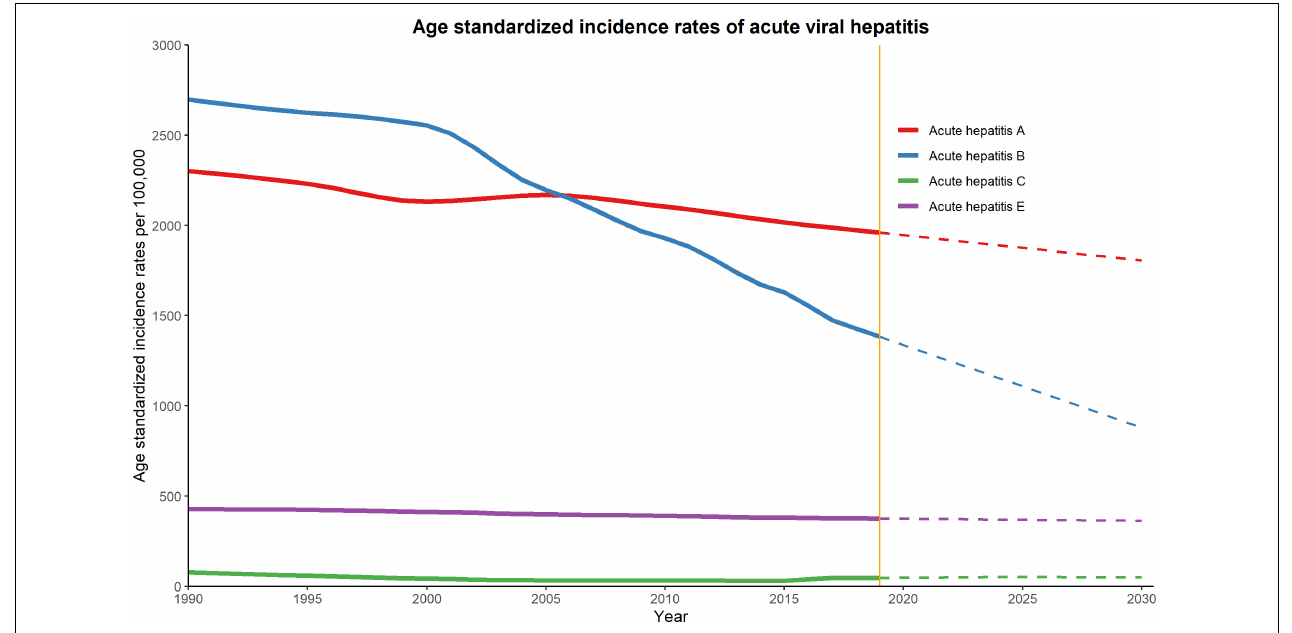
FIGURE 2 | Trends in observed (solid lines) and predicted (dashed lines) age-standardized incidence rate (ASIR) of acute viral hepatitis from 1990 to 2030 in China.